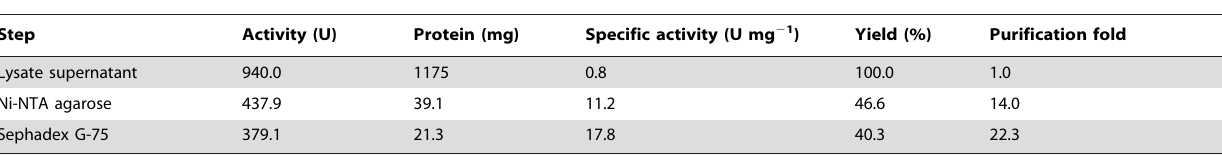
Table 1. Purification of recombinant Svi DyP.